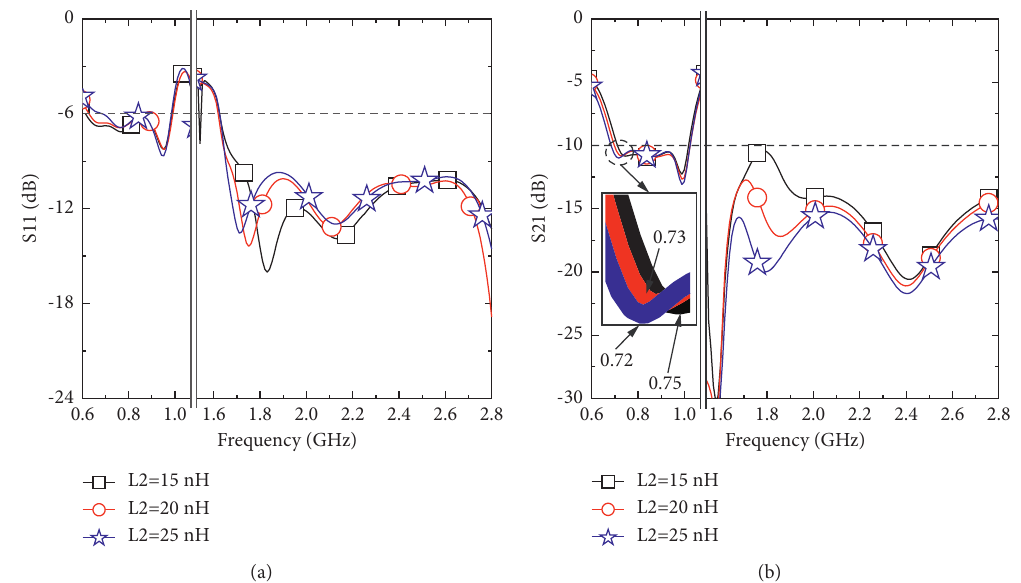
Figure 5: Simulated S-parameters of the proposed antenna with different values of L2. (a) S11. (b) S21.